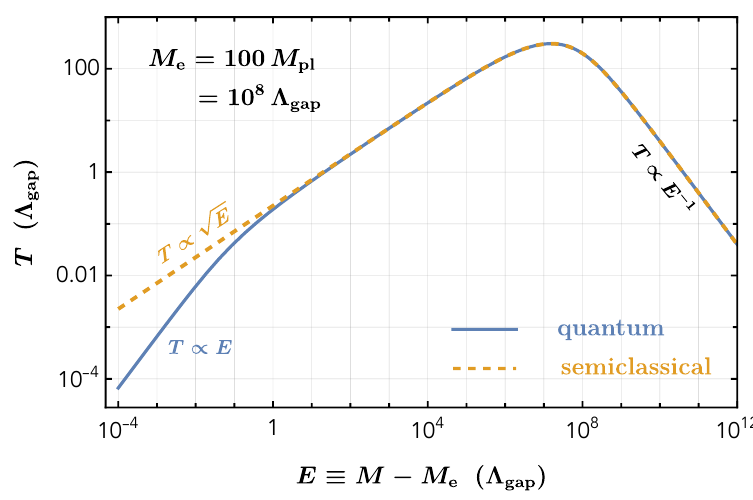
Figure 1 . The charged black hole temperature as a function of energy for M e = 100 M pl , which is equivalent to M e = 10 8 Λ gap and Λ gap = 10 − 6 M pl from (2.6). The power-law behaviors are labelled for the asymptotic regions. In the small energy region the quantum effect turns to reduce the black hole temperature for a fixed